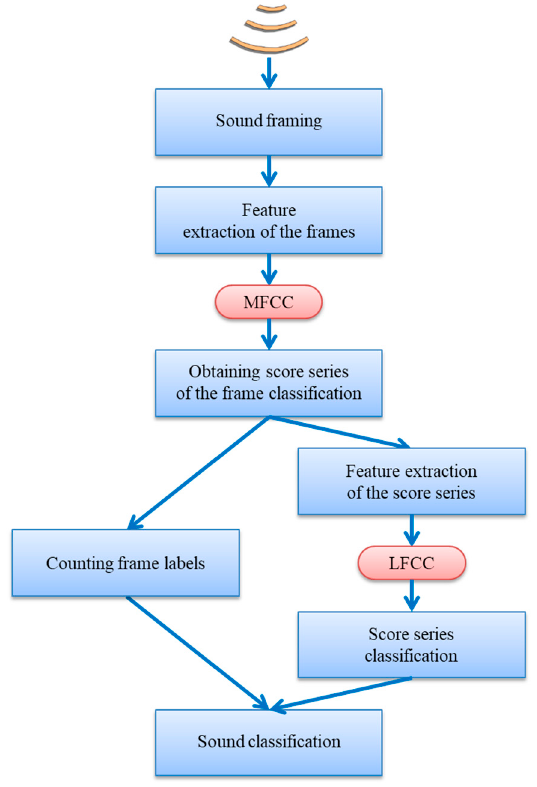
Figure 9. General schema for the classification procedure.